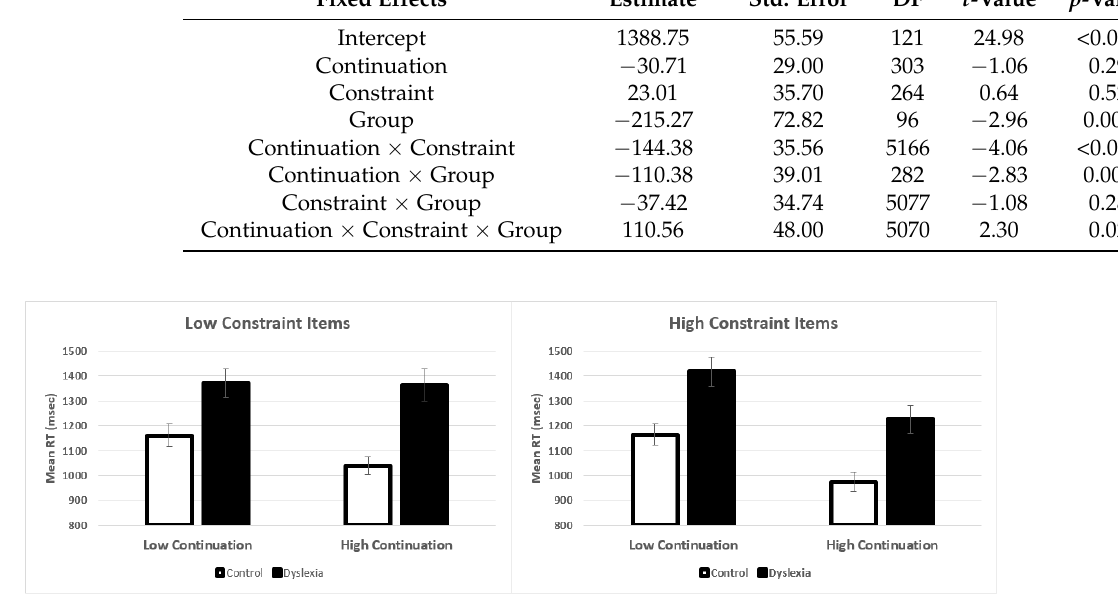
Figure 1. Mean reaction times. ( Left panel ) shows the results for the low-constraint items and the ( right panel ) shows the high-constraint items. Error bars show the standard error of the mean.